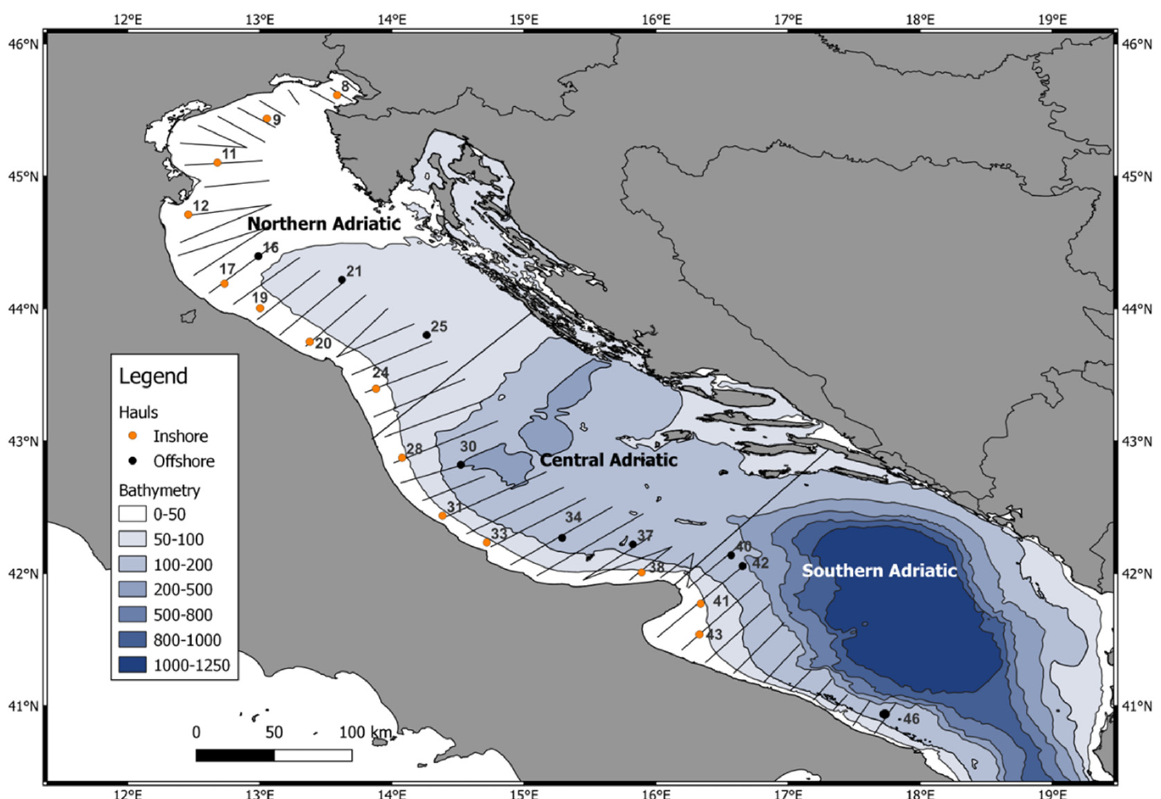
Figure 1. Surveyed subareas and the selected hauls (in orange the inshore hauls and in black the offshore hauls).